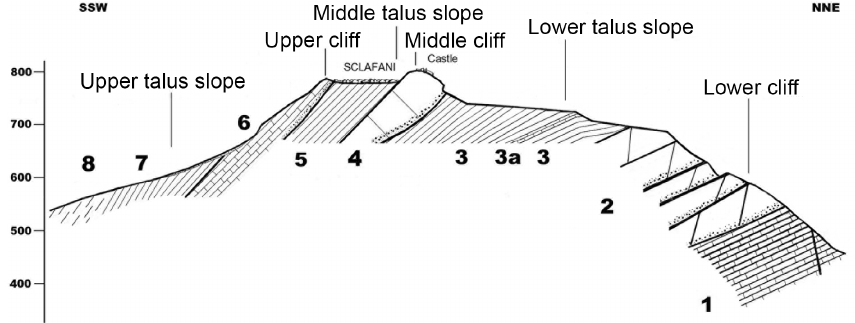
Figure 3. Schematic N–S geological and geomorphological profile (a, b) at Mt Sclafani. Details and explanation in the text; the location of the section is shown as A–B in Fig. 5. Note the sequences of caprocks and soft rocks enhanced by selective weathering and